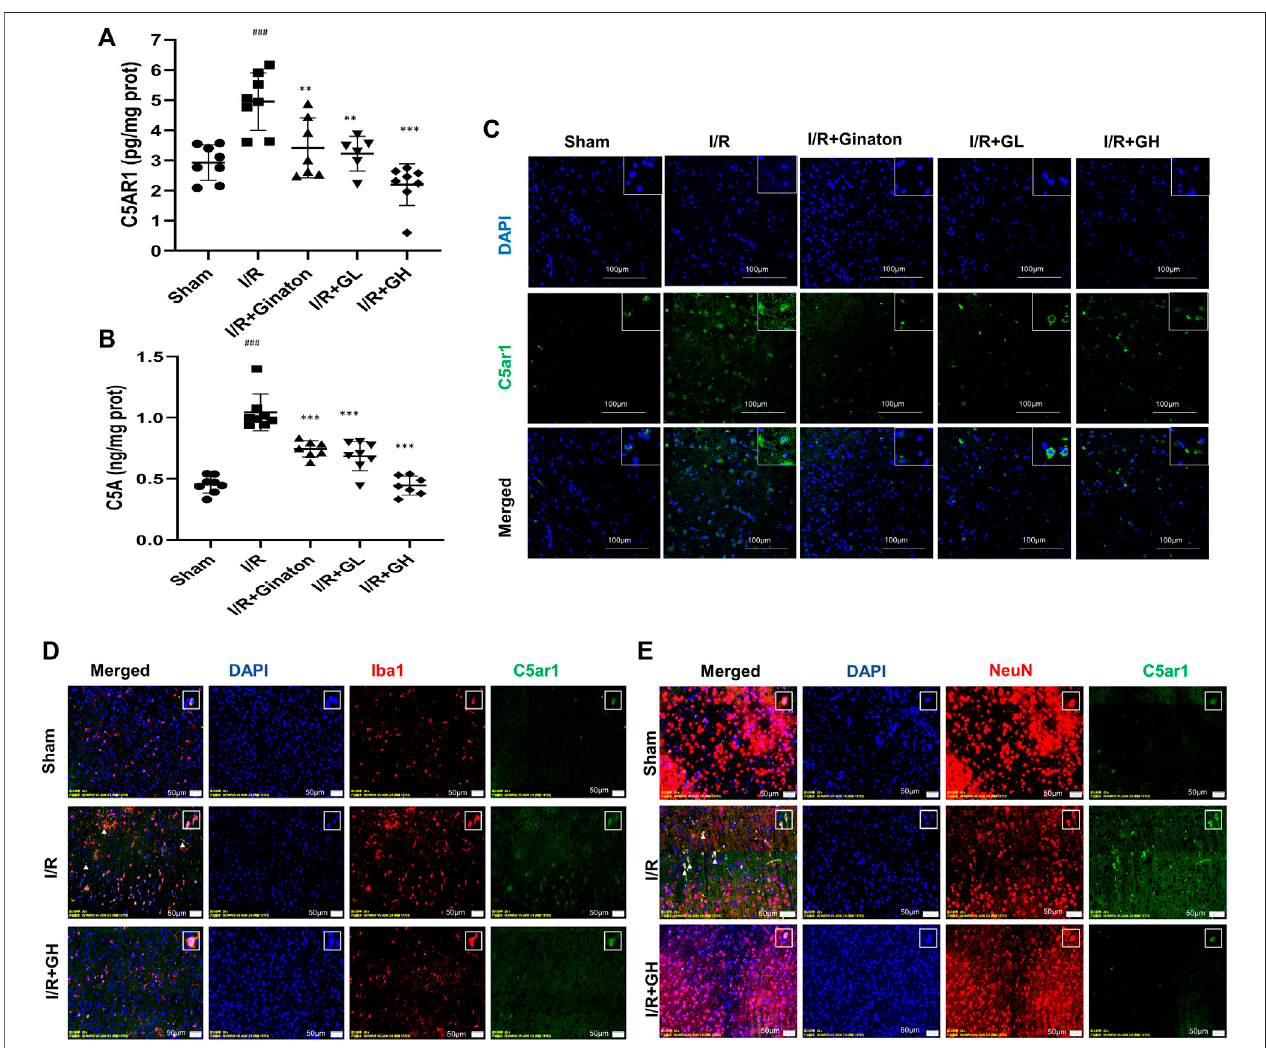
FIGURE 5 | GHI reduced the expression of C5AR1 and C5A in the cortex. (A – B) ELISA of C5AR1 and C5A ( n = 6 – 8); (C) IF for C5AR1 (green); (D) IF for C5AR1 (green) and Iba1 (red); (E) IF for C5AR1 (green) and NeuN (red); nuclei (blue). The white triangle indicates the expression of C5AR1 in neurons or microglia, scale